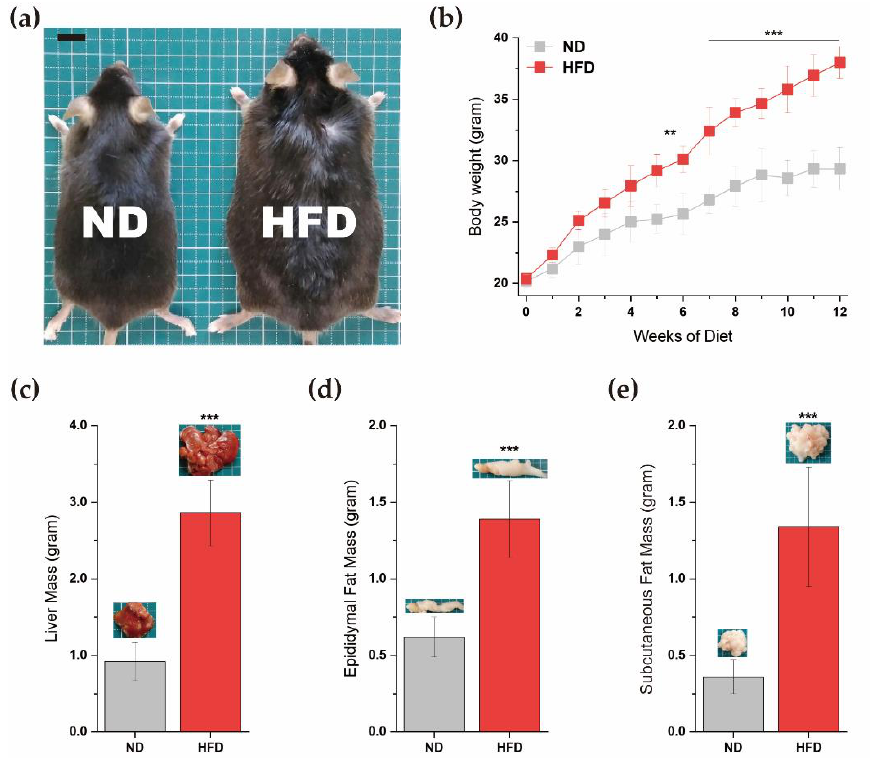
Figure 1. Comparison of the characteristics of the normal diet (ND) and high-fat diet (HFD) mouse groups (n = 5 per group). All measurements for the four characteristic parameters were performed after 12 weeks of diet exposure. ( a ) The appearances of representative ND and HFD mice (Scale bar = 1 cm) and ( b ) a chart of the time course of changes in body weight in each group, ( c ) liver mass (gram) in each group, ( d ) epididymal fat mass (gram) in each group, and ( e ) subcutaneous fat mass (gram) in each group (** p ≤ 0.01, *** p ≤ 0.001). ( c – e ) include representative images of the liver, epididymal fat, and subcutaneous fat, respectively. All static data are presented as mean ± standard deviation. Biosensors 2021 , 10 , x